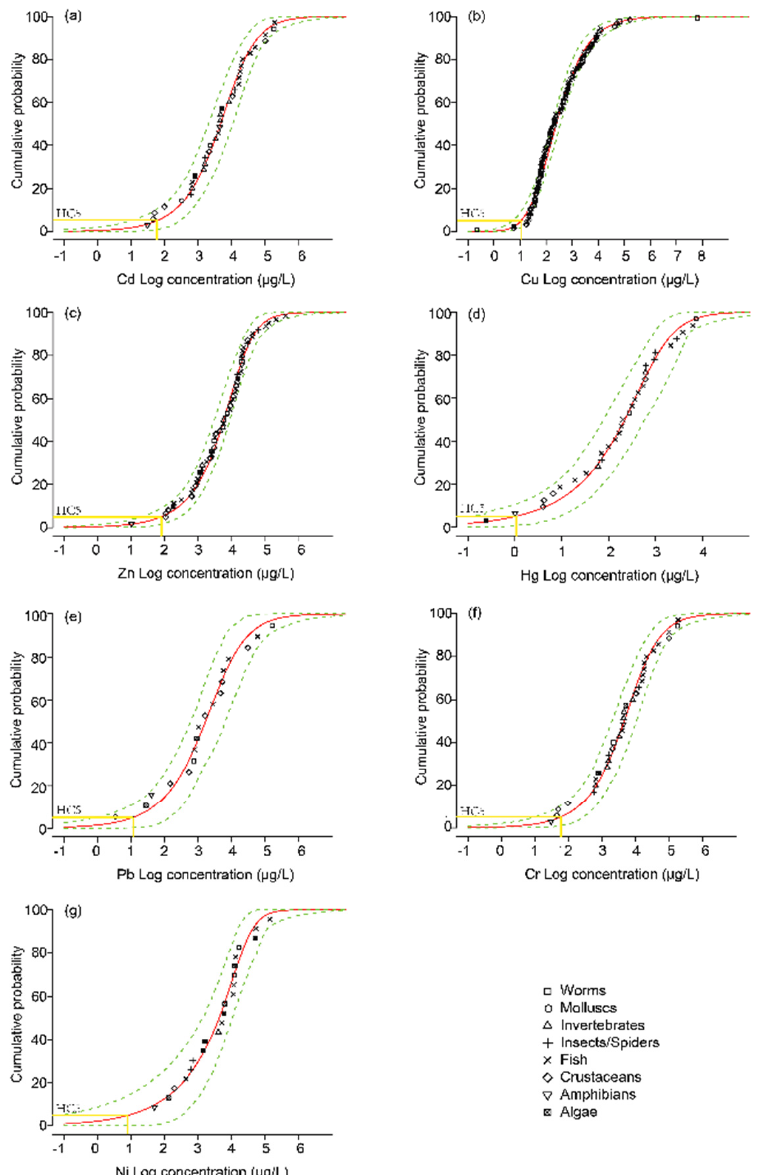
Figure 4. Species sensitivity distribution curves of seven heavy metals to all species. ( a )-SSD curve for Cd; ( b )-SSD curve for Cu; ( c )-SSD curve for Zn; ( d )-SSD curve for Hg; ( e )-SSD curve for Pb; ( f )-SSD curve for Cr; ( g )-SSD curve for Ni.